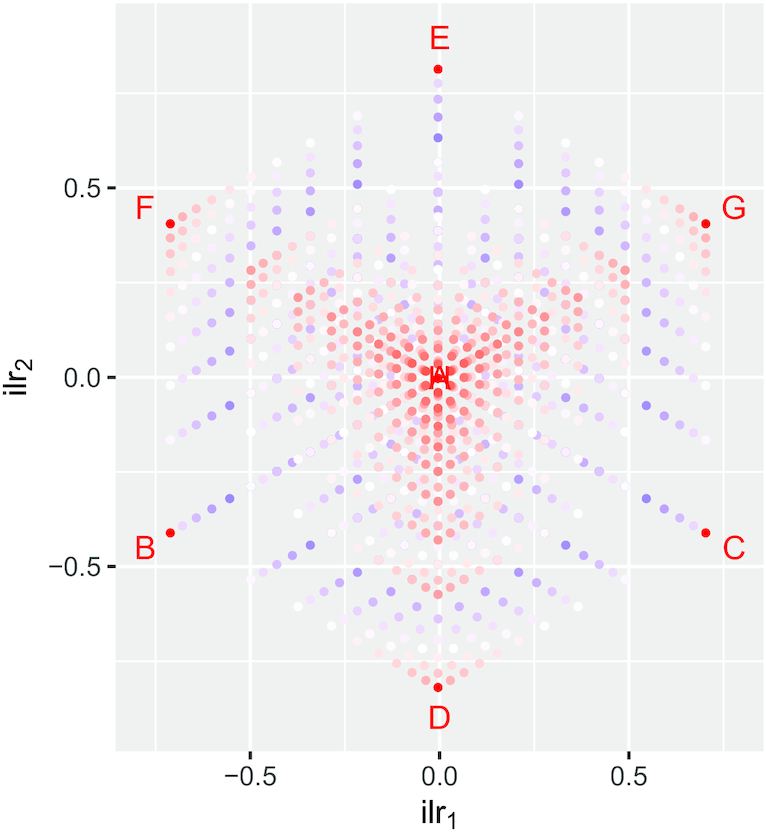
An isometric log-ratio transformation of the 1000 (x, y, \documentclass[12pt]{minimal}
\usepackage{amsmath}
\usepackage{wasysym}
\usepackage{amsfonts}
\usepackage{amssymb}
\usepackage{amsbsy}
\usepackage{upgreek}
\usepackage{mathrsfs}
\setlength{\oddsidemargin}{-69pt}
\begin{document}
}{}$z$\end{document}) triples in Figure 1A. Isometric log-ratios define a family of transformations rather than a single transform and we have used the specific ilr transformation \documentclass[12pt]{minimal}
\usepackage{amsmath}
\usepackage{wasysym}
\usepackage{amsfonts}
\usepackage{amssymb}
\usepackage{amsbsy}
\usepackage{upgreek}
\usepackage{mathrsfs}
\setlength{\oddsidemargin}{-69pt}
\begin{document}
}{}$\mathrm{ilr}_1 = -\sqrt{1/2}\log _{10}(x/y), \mathrm{ilr}_2=-\sqrt{2/3}\log _{10}(\sqrt{xy}/z)$\end{document}, which corresponds to the view of the clr-plane in Figure 1C along the ray (1,1,1). Points are colored and the extreme points are labeled as in Figure 1—note that corner points A and H map to the same point.